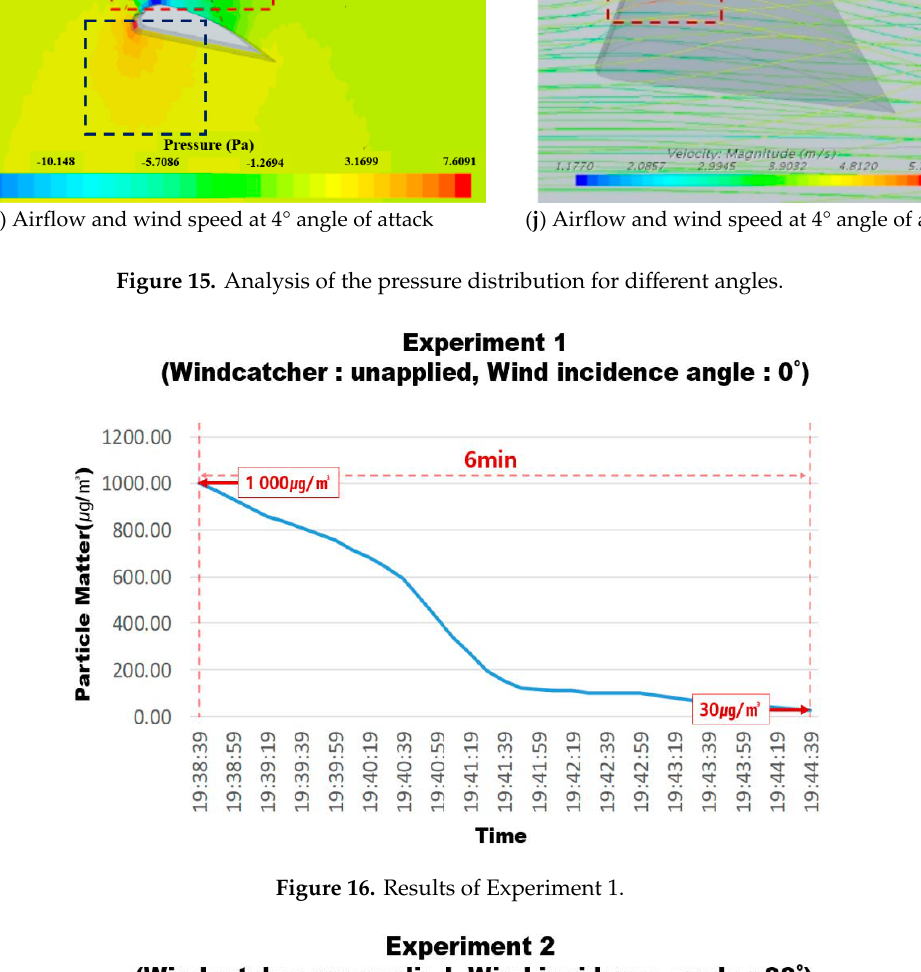
Figure 18. Results of Experiment 3.